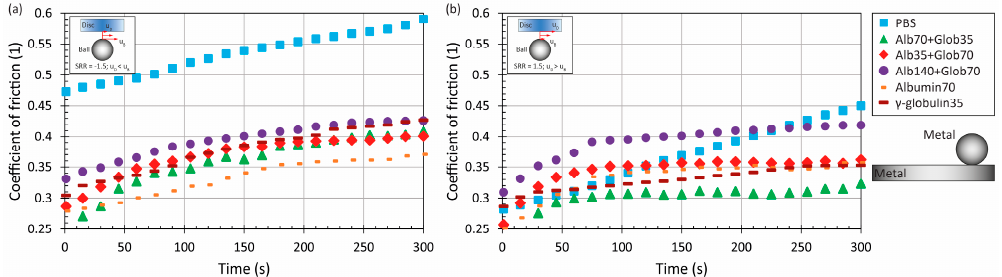
Figure 6. Development of CoF as a function of time for metal-on-metal pair at higher mean speed under negative ( a ) and positive ( b ) sliding conditions for various model fluids.